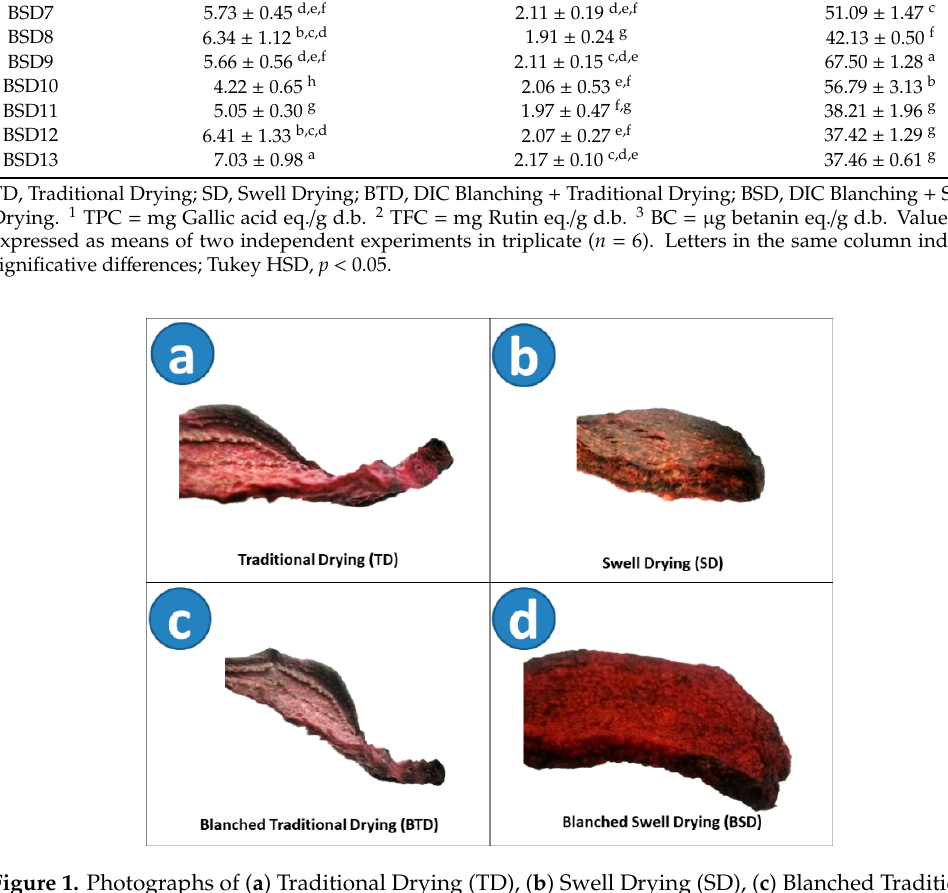
Table 1. Total Phenolics Content (TPC), Total Flavonoids Content (TFC), and Betanin Concentration (BC) of red dried beetroots.